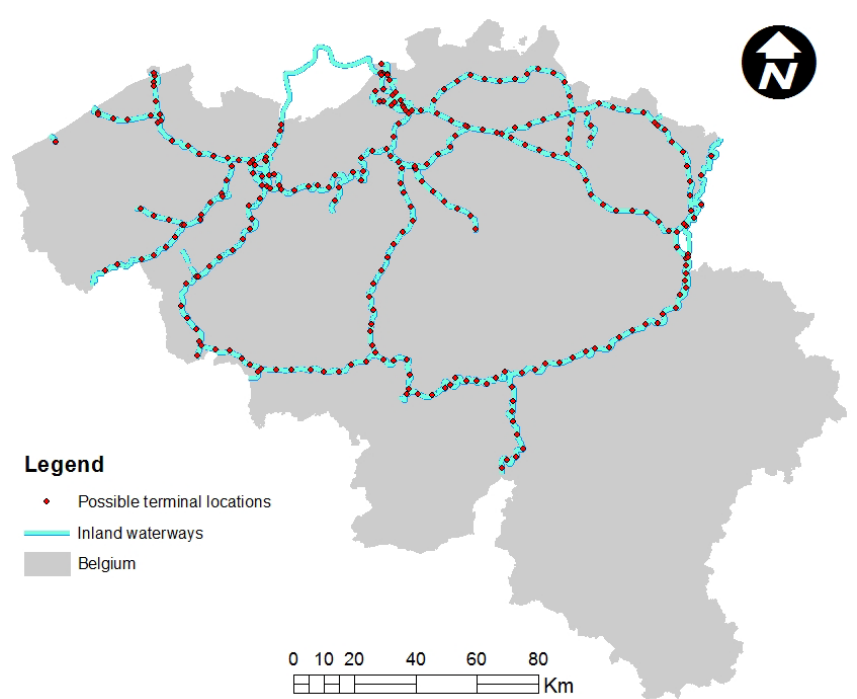
Figure 4. Possible terminal locations along inland waterways, using network